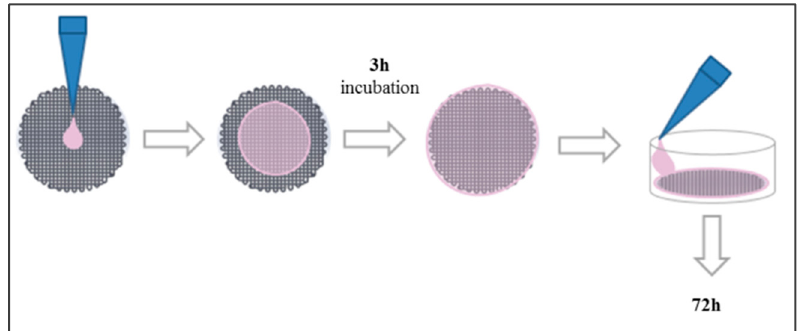
Figure 11. Cell seeding protocol on PCL scaffolds.